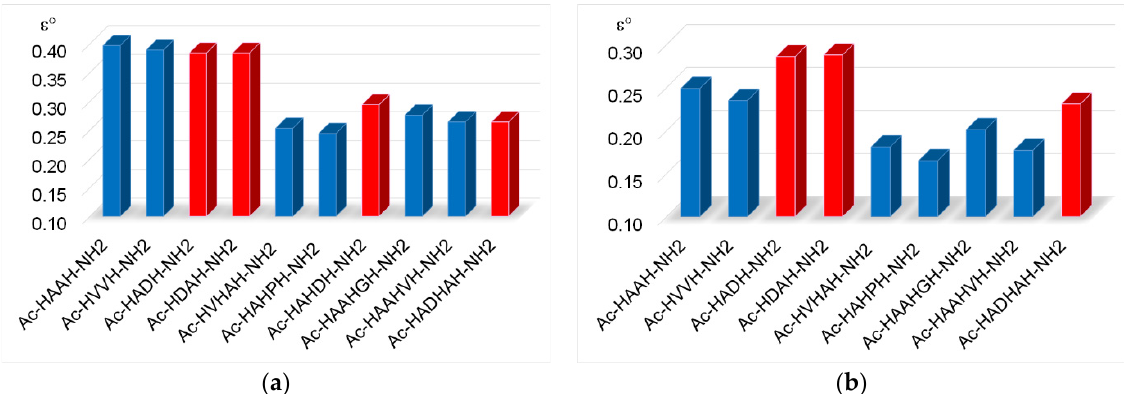
Figure 9. Redox potentials (vs. NHE) of [CuL] (a) and [CuH − 2 L] (b) complexes of aspartic acid containing ( ■ ) and other multihistidine peptides ( ■ ) (Data from refs. [13,27]).